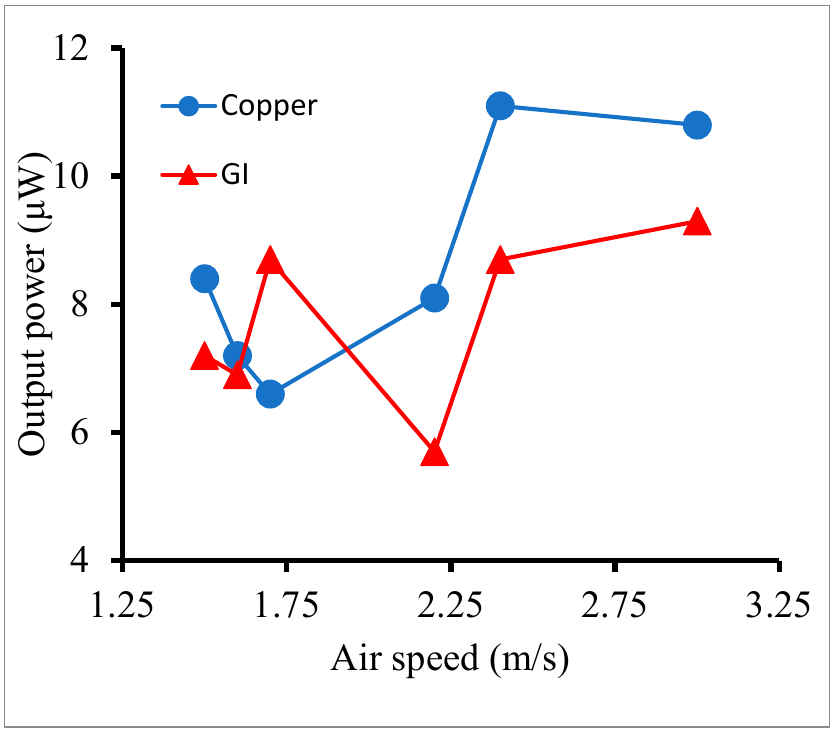
Figure 8. Output power with the speed of air. The square-shaped antenna gap was 24 × 24 cm 2 , temperature was 32 °C, humidity was 40%, gross area of each antenna was 72 × 72 cm 2 , the wire diameter was 2.5 mm, and the height of the antenna from the ground was 30 m.